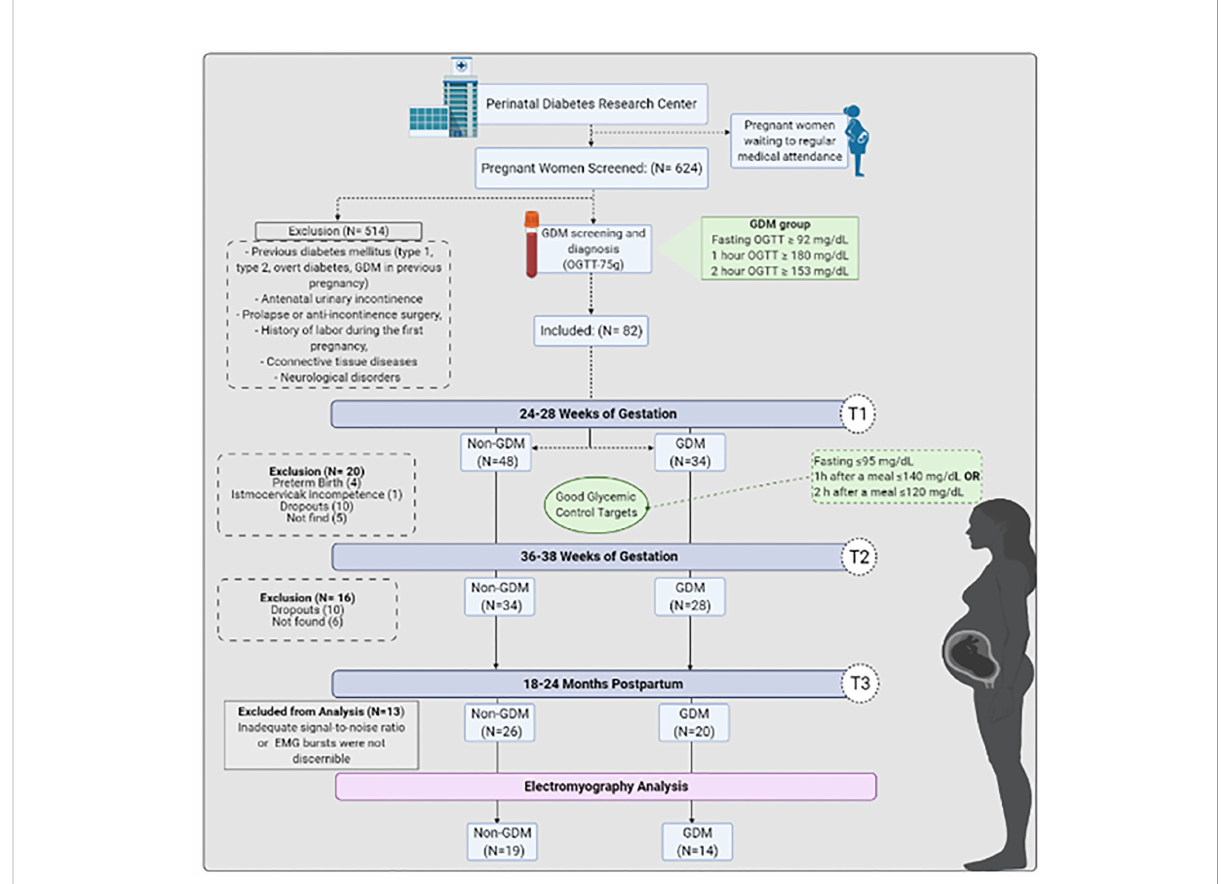
FIGURE 3 GDM women ’ s screening, diagnosis, enrollment, follow-up analysis and reasons for signal exclusion from